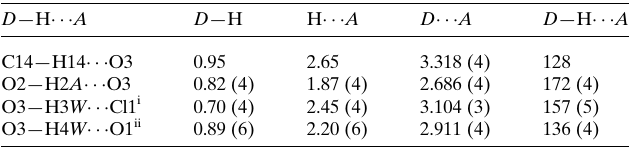
Table 1 Hydrogen-bond geometry (A˚ , (cid:5)